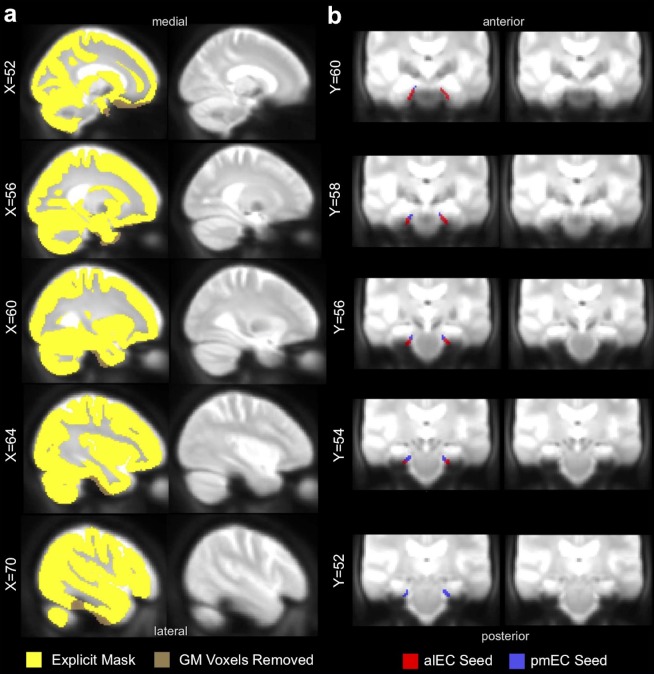
Signal drop out demonstrated with group-mean functional images.(a) A group-level explicit mask (yellow) was created by removing GM voxels of low signal (<40% of the mean signal across the gray matter; shown in brown) from a gray matter mask. This explicit mask was applied to all functional connectivity analyses to ensure regions of low signal did not contribute to results. (b) alEC (red) and pmEC (blue) template space seeds are overlaid on the group-mean functional image to visually demonstrate the average signal in these regions. For functional connectivity analyses, voxels of low signal were removed from each ROI on a participant-level basis.